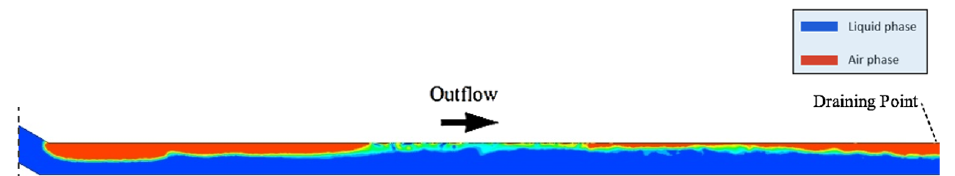
Figure 12. CFD simulation results of the mixed two-phase flow during pipeline